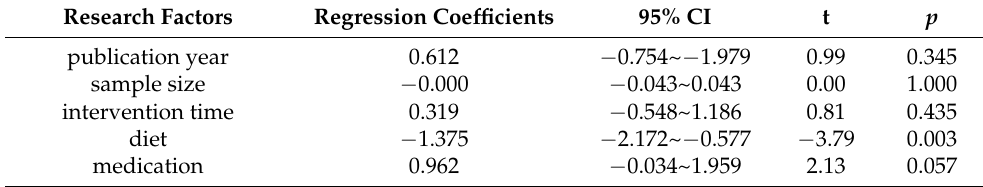
Table 6. Meta regression analysis of heterogeneous factors of alanine aminotransferase